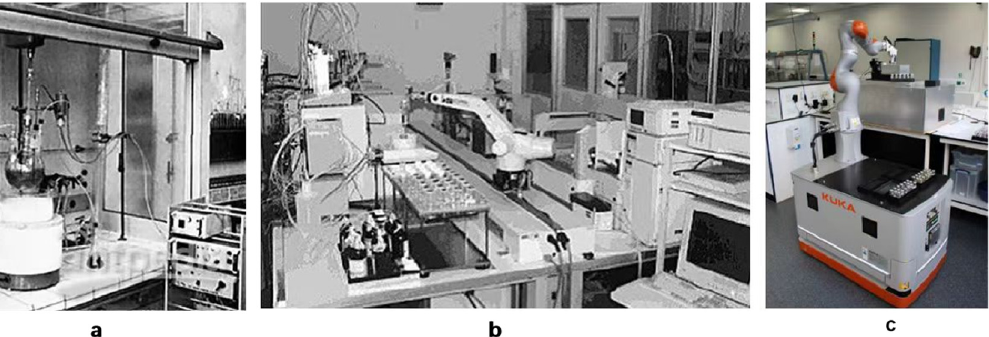
Figure 1. Evolution of the Automated Synthesis Machine platform: ( a ) 1970s; ( b ) 1999; ( c ) 2020.